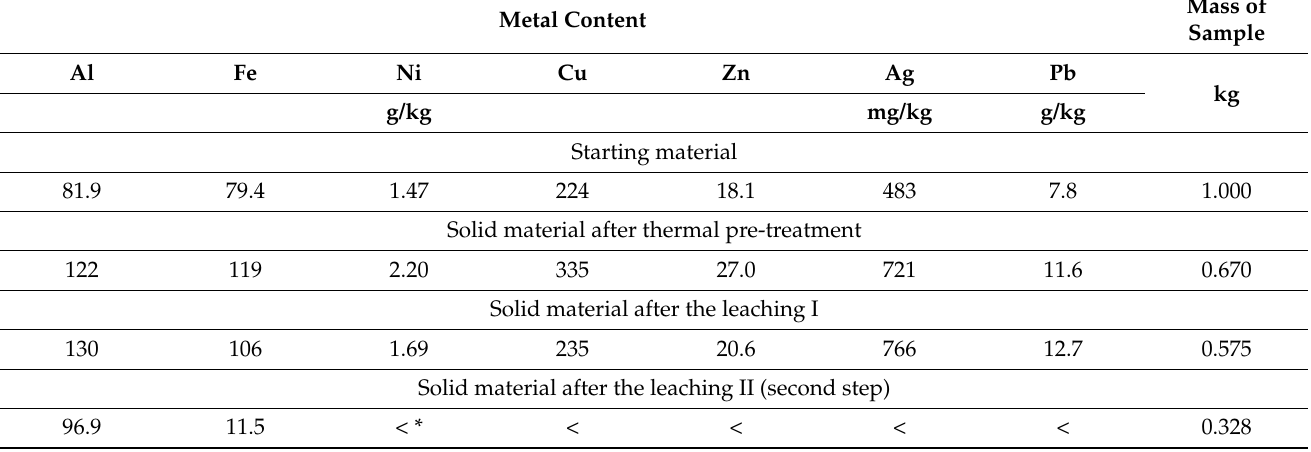
Table 1. Metal content in the starting WPCBs material after thermal pre-treatment at the temperature